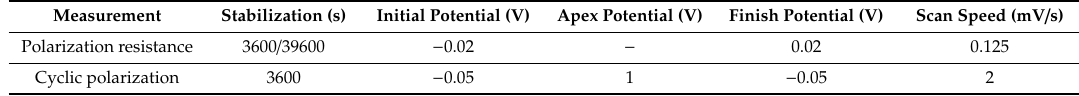
Table 1. The conditions of individual electrochemical